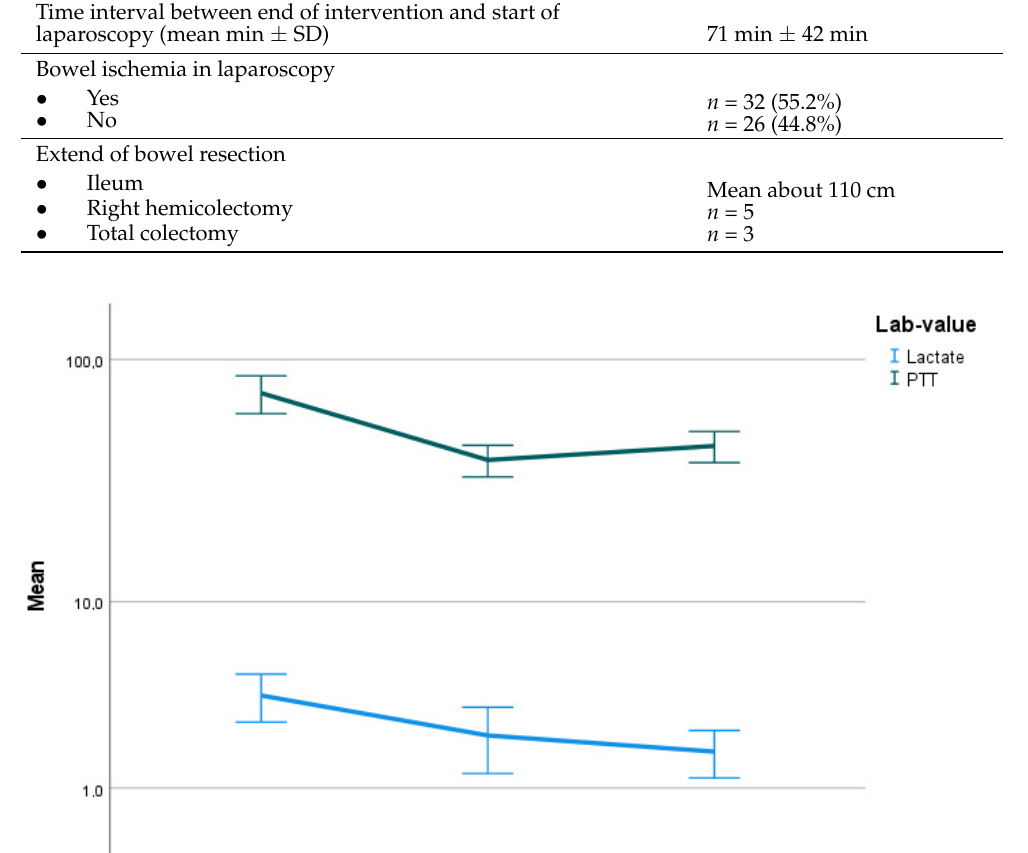
Figure 3. Serum lactate levels on arrival at hospital (blue), after 12 h (red) and after 24 h (green).